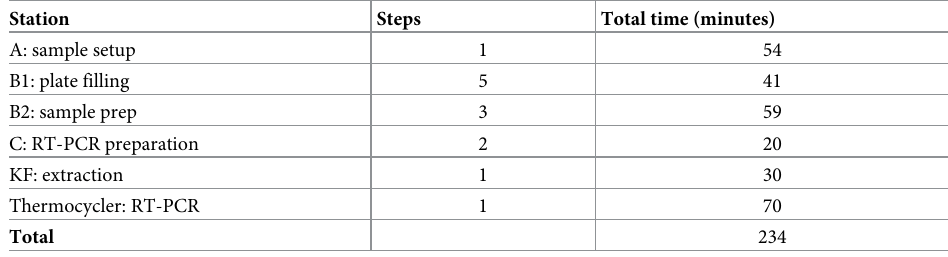
Table 1. Number of steps and running times in minutes for a full run with 96 samples across the different sta- tions. Station A and B1 can be run